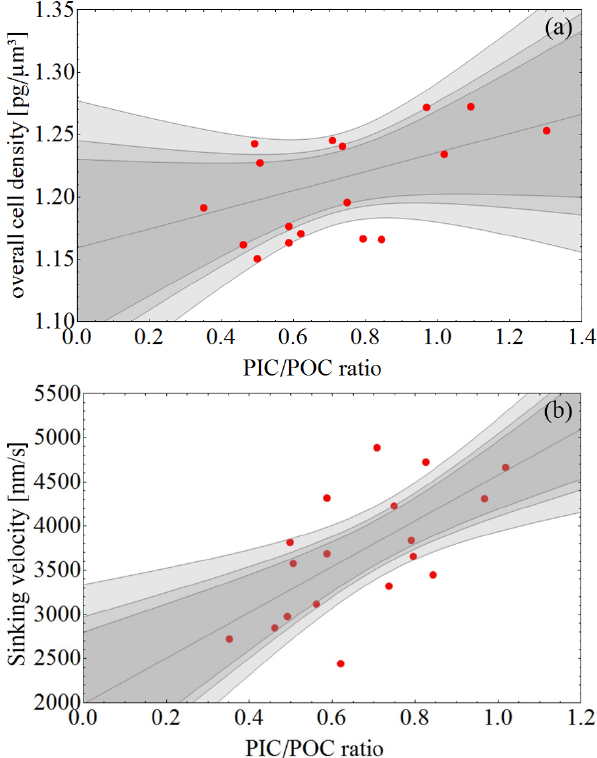
Figure 6. The calculated PIC / POC ratio as a function of (a) max- imum layer of coccoliths and (b) number of coccoliths is given. In (b) the black dots refer to coccospheres with a maximum of one layer, the yellow to those with a maximum of two layers, the blue to those with a maximum of three layers and the white to those with a maximum of four layers. The fitted slopes as well as the calculated 0.9, 0.95 and 0.99 confidence levels are given by the grey lines.